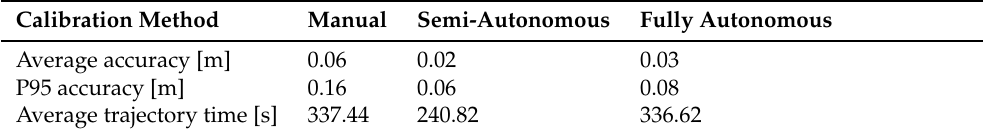
Table 2. Overview of calibration results.